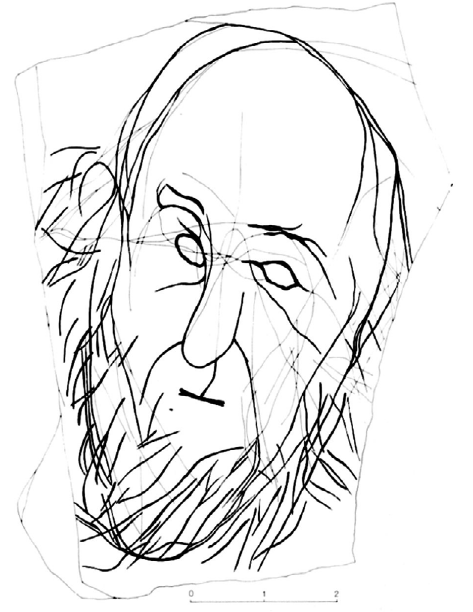
Figure 24. Group ε, example of Hand ε1: frontal portrait of old man (from Airvaux and Pradel, 1984).